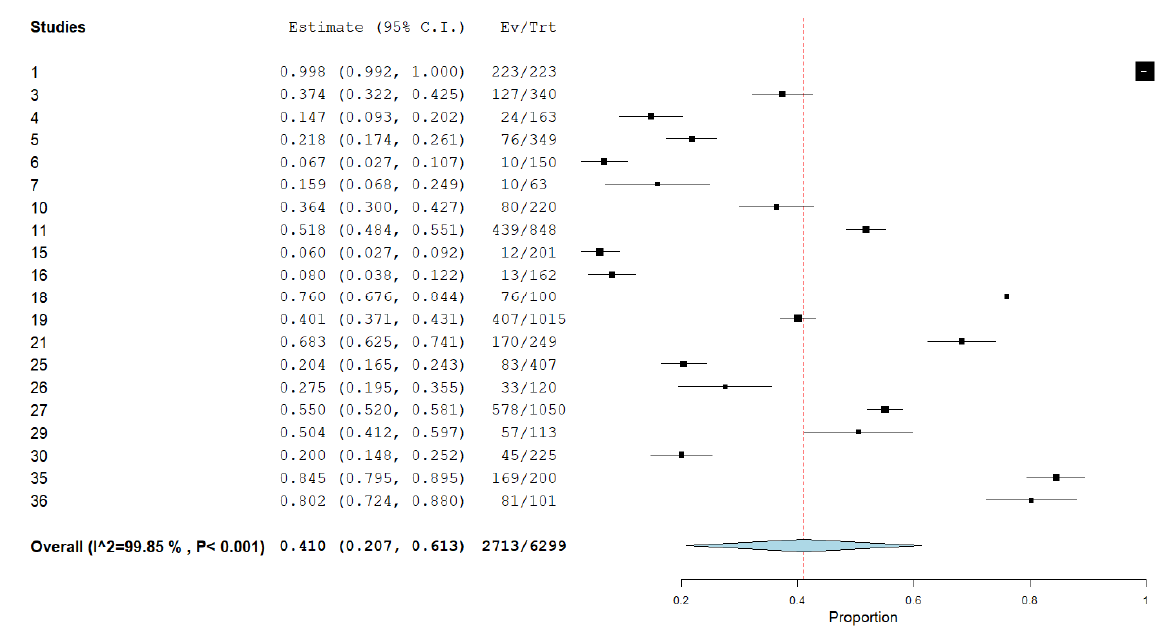
Figure 2. The aggregate prevalence of